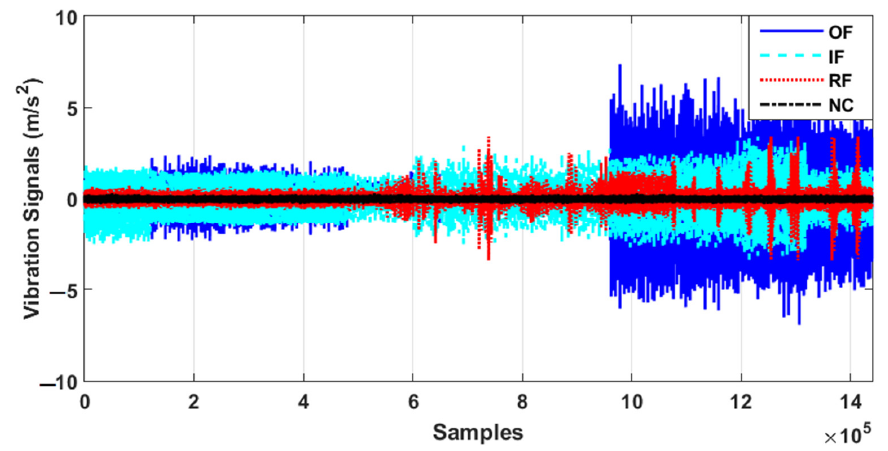
Figure 3. The original raw signals of the CWRUBD.